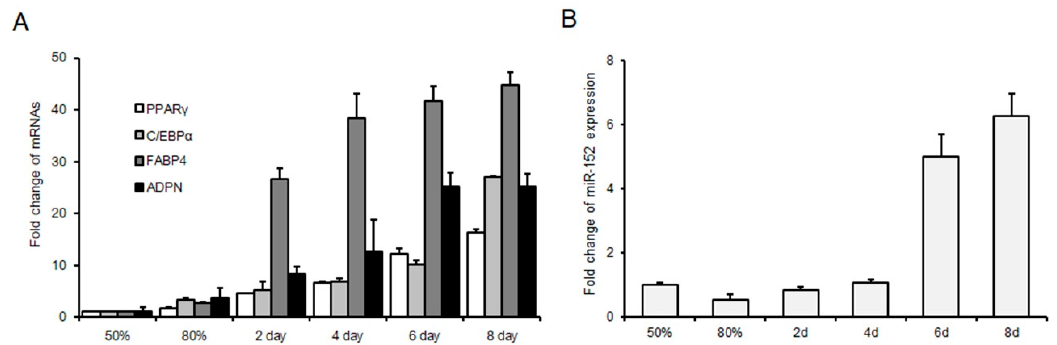
Figure 1. MicroRNA (miR)-152 is up-regulated during 3T3-L1 preadipocyte differentiation. ( A ) The expression of adipogenic markers in 3T3-L1 cells in GM 50% and 80% and DM for two, four, six and eight days. ( B ) The expression of miR-152 in 3T3-L1 cells in GM 50% and 80% and DM for two, four, six and eight days. Results are presented as means ± standard deviation (SD).